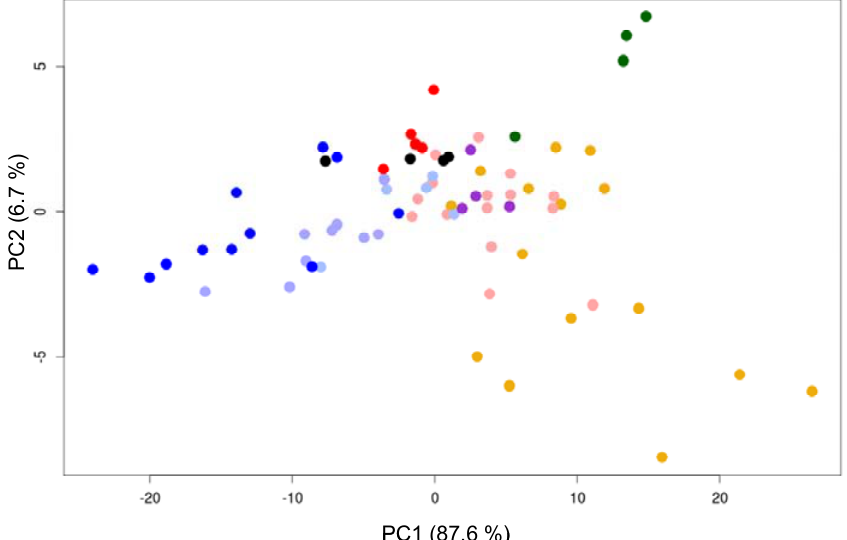
Figure 6. Functional PCA join results of original cyclic voltammetric data obtained with Au WE in different adulterated and non-adulterated milk samples. La Serenisima M ( ● ); MSM ( ● ); USM ( ● ); Sancor M ( ● ); MSM ( ● ); USM ( ● ). Adulterant concentrations ranged between 2.43 and 0.1214 g·L − 1 for urea and between 1.7 and 0.085 g·L − 1 for melamine. For USM and MSM a graduation in the color intensity represents the adulteration percentage from 1 to 20%, where increasing intensity corresponds to a higher